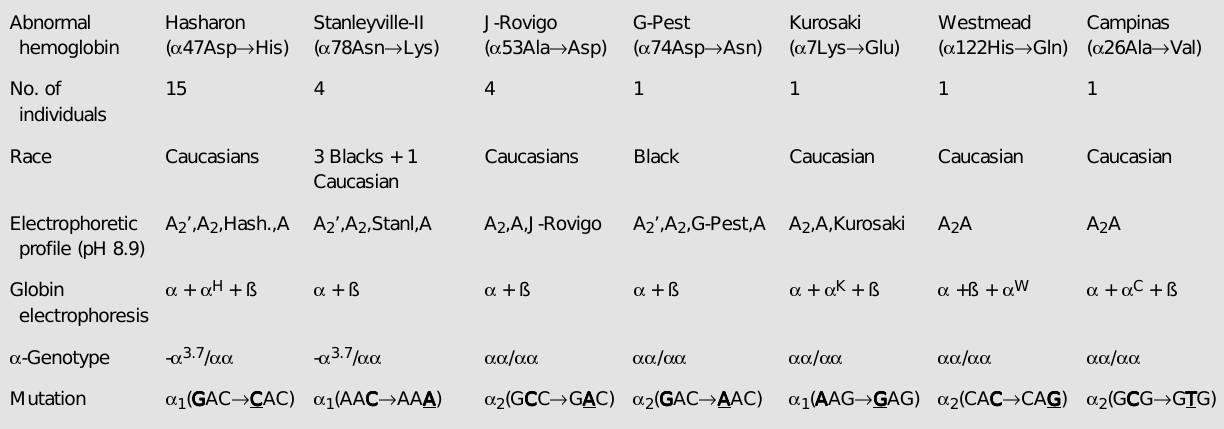
Table 2 - Structural alterations in